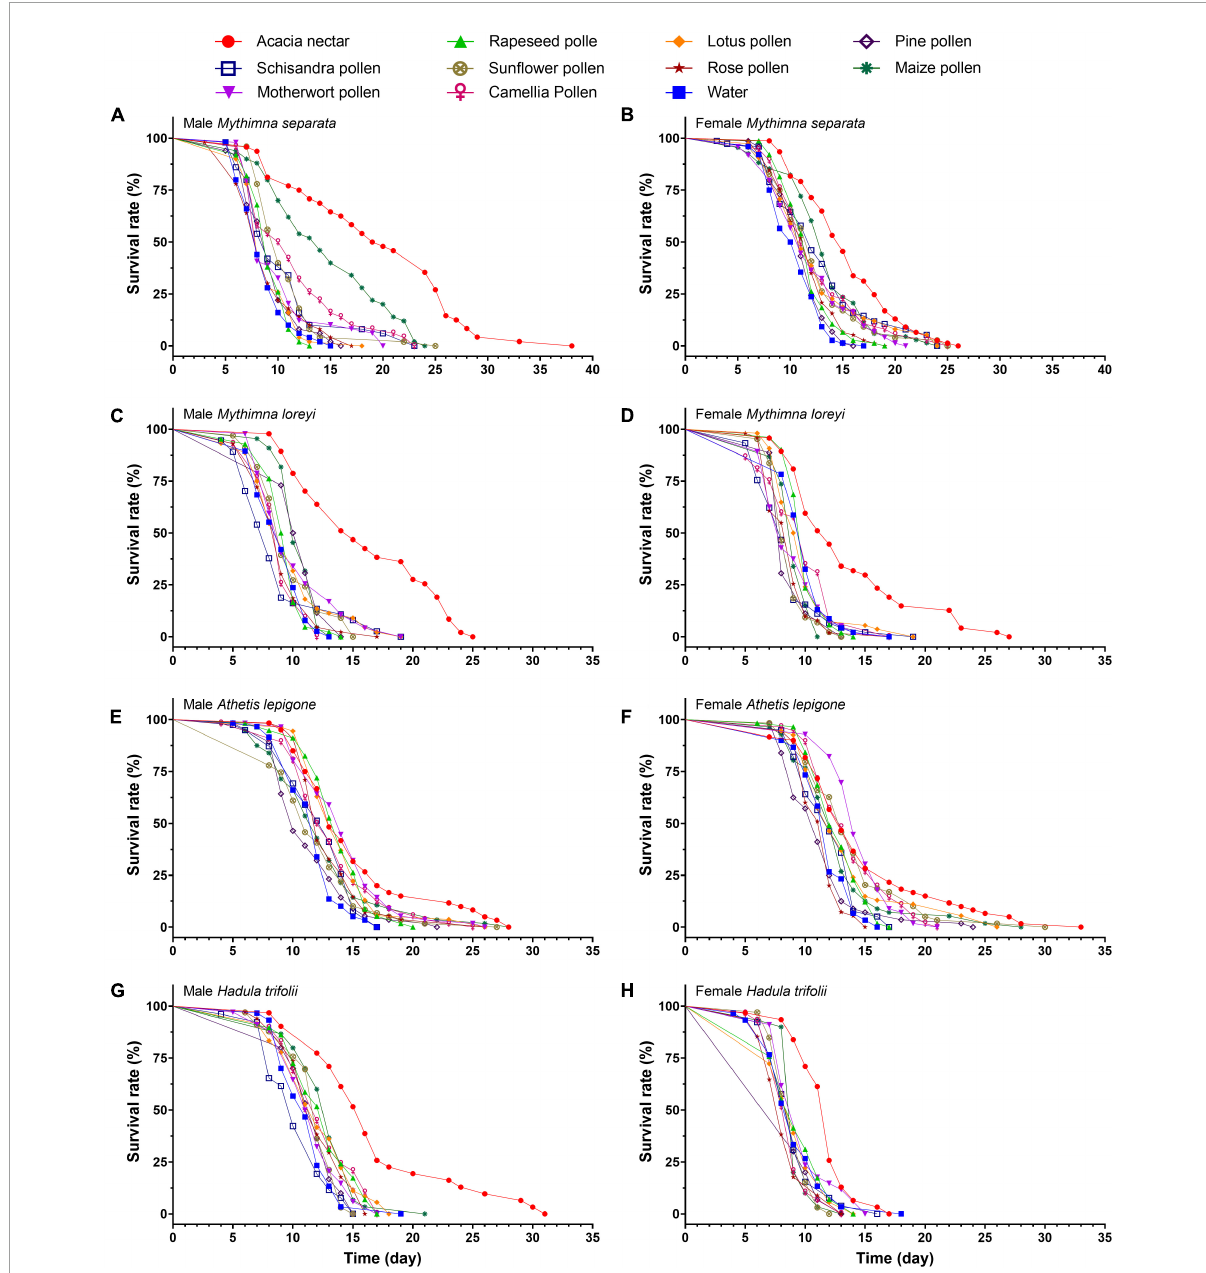
FIGURE2 Age-specific survival rate of male and female adults of Mythimna separata (A,B) , Mythimna loreyi (C,D) , Athetis lepigone (E,F) , and Hadula trifolii (G,H) on different diets.